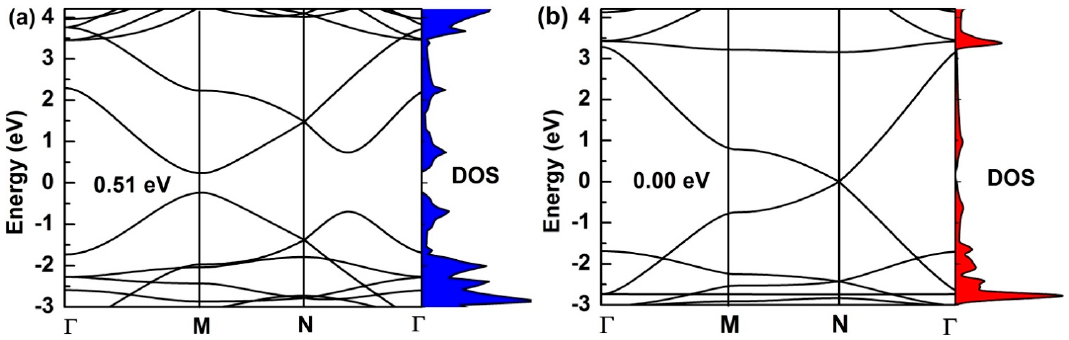
Figure 3. The electronic density of states and band structure for ( a ) α -graphyne and ( b ) β -graphyne. The red and blue areas represent the electronic density of states corresponding to the band structure.